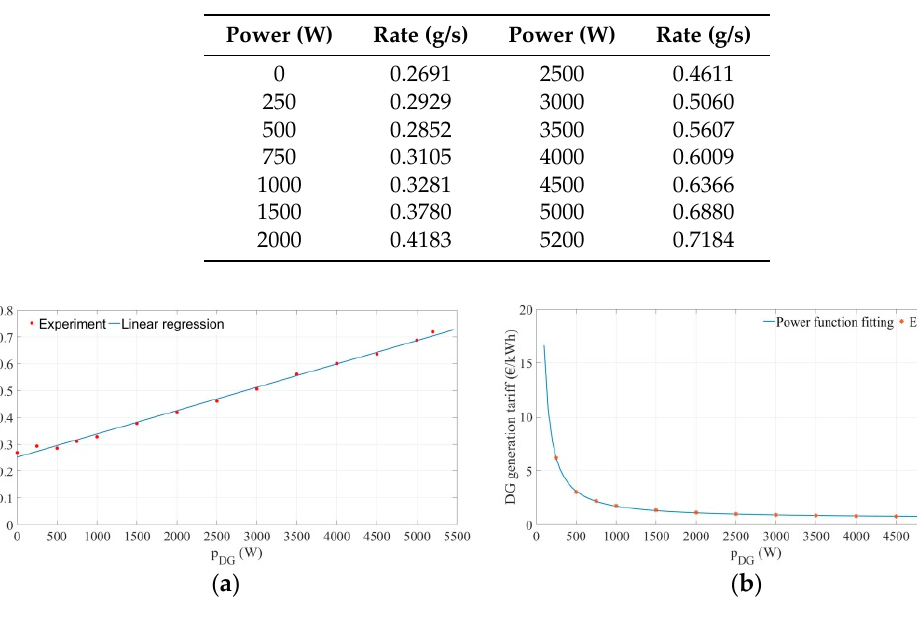
Figure 13. ( a ) DG consumption rate versus output power; ( b ) DG generation tariff versus output power.